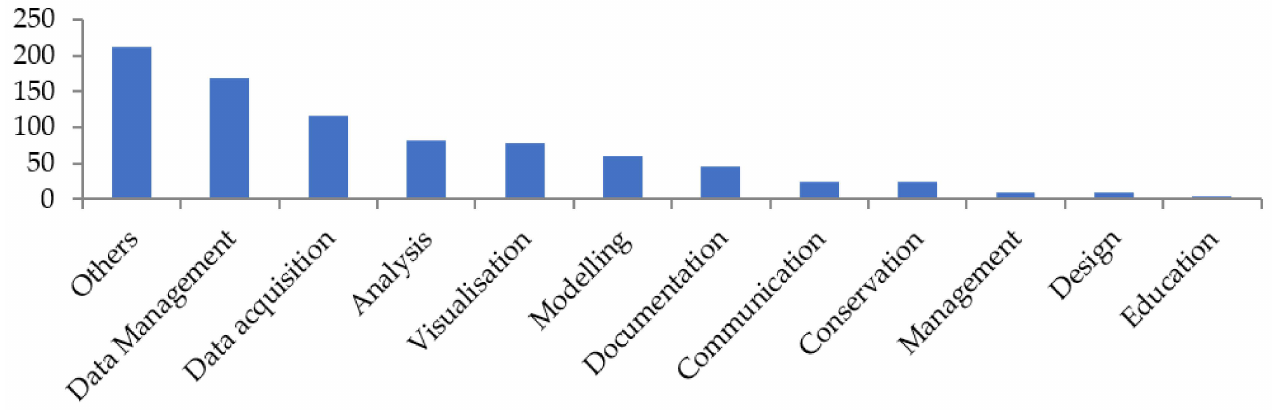
Figure 9. Topic areas in the field of 3D modelling in humanities (Online survey, n = 825 conducted in